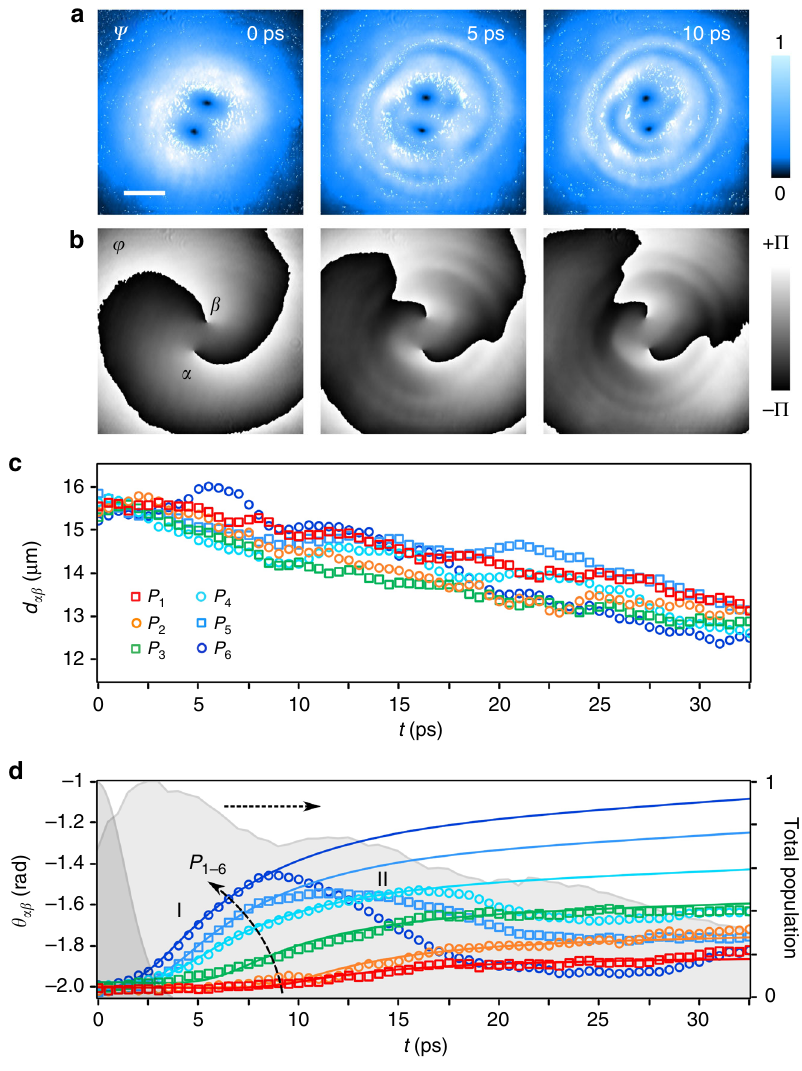
Fig. 1 Vortex – vortex rotational pair dynamics. Polariton ( a ) amplitude and ( b ) phase maps at different times ( t = 0, 5, and 10 ps) for the initial total polariton population P 6 . The two phase singularities are visible as small dark spots in a and labeled as α and β in b . Intervortex ( c ) distance and ( d ) angle for six initial total polariton populations ( P 1 – P 6 ). The labels I and II indicate the effective nonlinear effect and its associated rotational regime (see text). In d the open symbols are the experimental points and the solid lines represent fi tting curves using the theoretical toy-model introduced in the Supplementary Note 6. The six pump powers correspond to the following initial populations: P 1 – 6 ≡ 60 × 10 3 , 150 × 10 3 , 300 × 10 3 , 0.6 × 10 6 , 1.0 ×10 6 , and 1.5 × 10 6 polaritons. The background shaded area in d depicts a time-series of the total polariton population plotted against the normalized y -axis to the right, while the darker half-Gaussian envelope on the left represents the resonant pumping temporal pulse pro fi le. Please note that this time envelope, together with the space maps in the fi rst frame ( t = 0 ps) of a , b jointly represent the full spatiotemporal-phase con fi guration of the photonic pump pulse, setting the initial condition of the polariton fl uid. The time zero ( t = 0) of the dynamics has been chosen at its arrival, ~2.5 ps before the maximum of the total emission. The scale bar to the maps is 20 μ